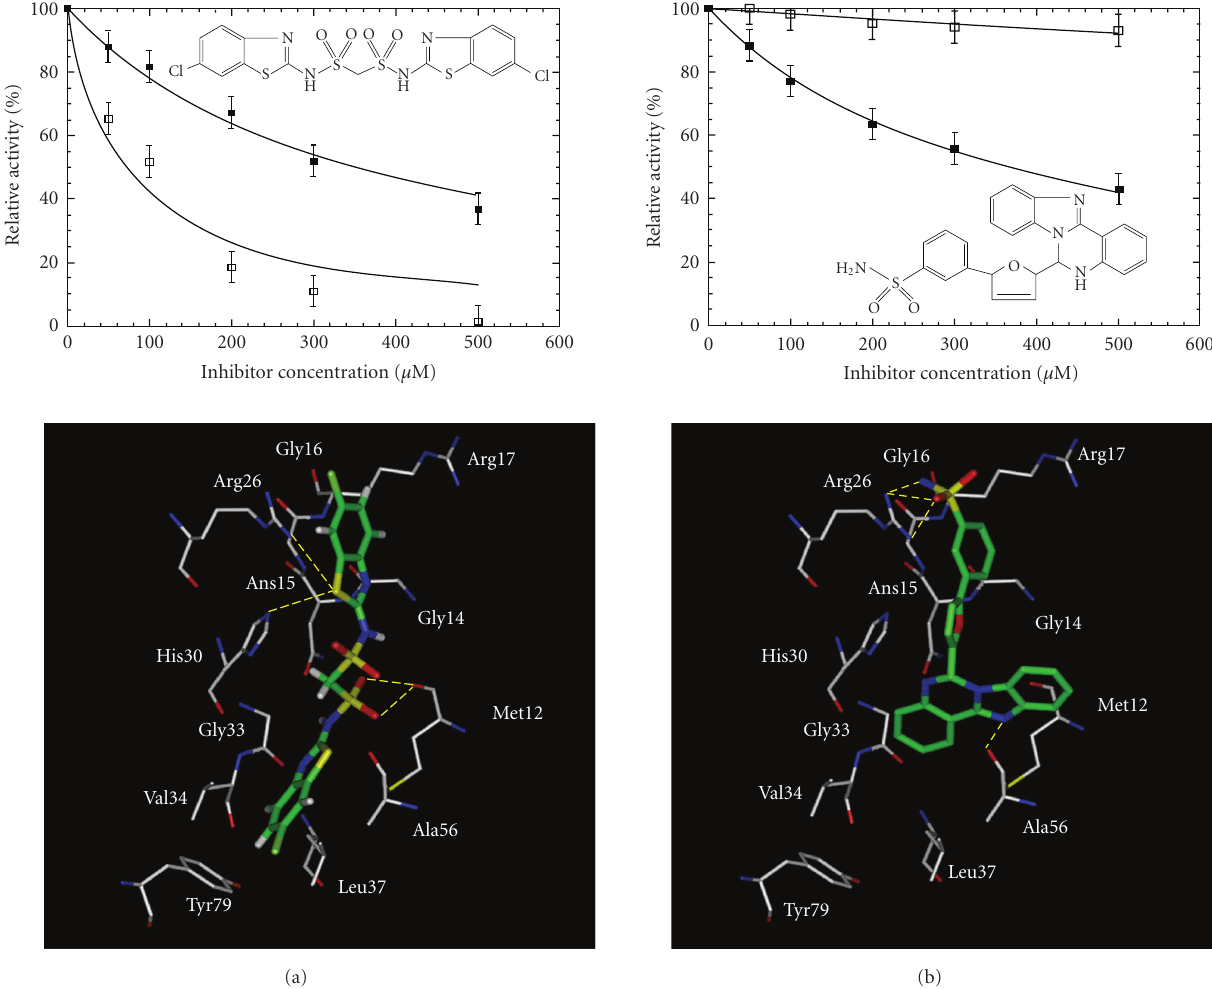
Figure 3: Computer virtual screening of the H. pylori UPPS inhibitors. Two compounds, BTB06061 shown in (a) and HTS04781 in (b), were identified from the computer fitting of the Maybridge compounds into the active site of E. coli and H. pylori UPPS. The data of enzyme activities in the presence of di ff erent concentrations of the inhibitors were used to determine the IC 50 values of the inhibitors. The compounds displayed IC 50 of 350 and 363 μ M, respectively, in inhibiting H. pylori UPPS activity. However, the IC 50 of BTB06061 became 71 μ M in inhibiting E. coli UPPS and HTS04781 was almost inactive against the enzyme. The modeled structures of the inhibitor bound in the active site of H. pylori UPPS are shown at the